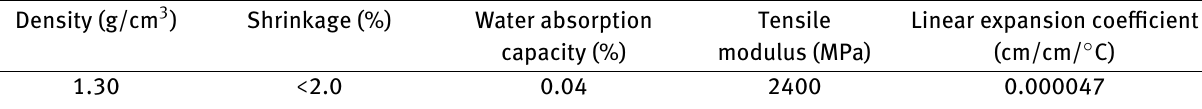
Table 1: Parameters of PEEK powder Density (g/cm 3 )